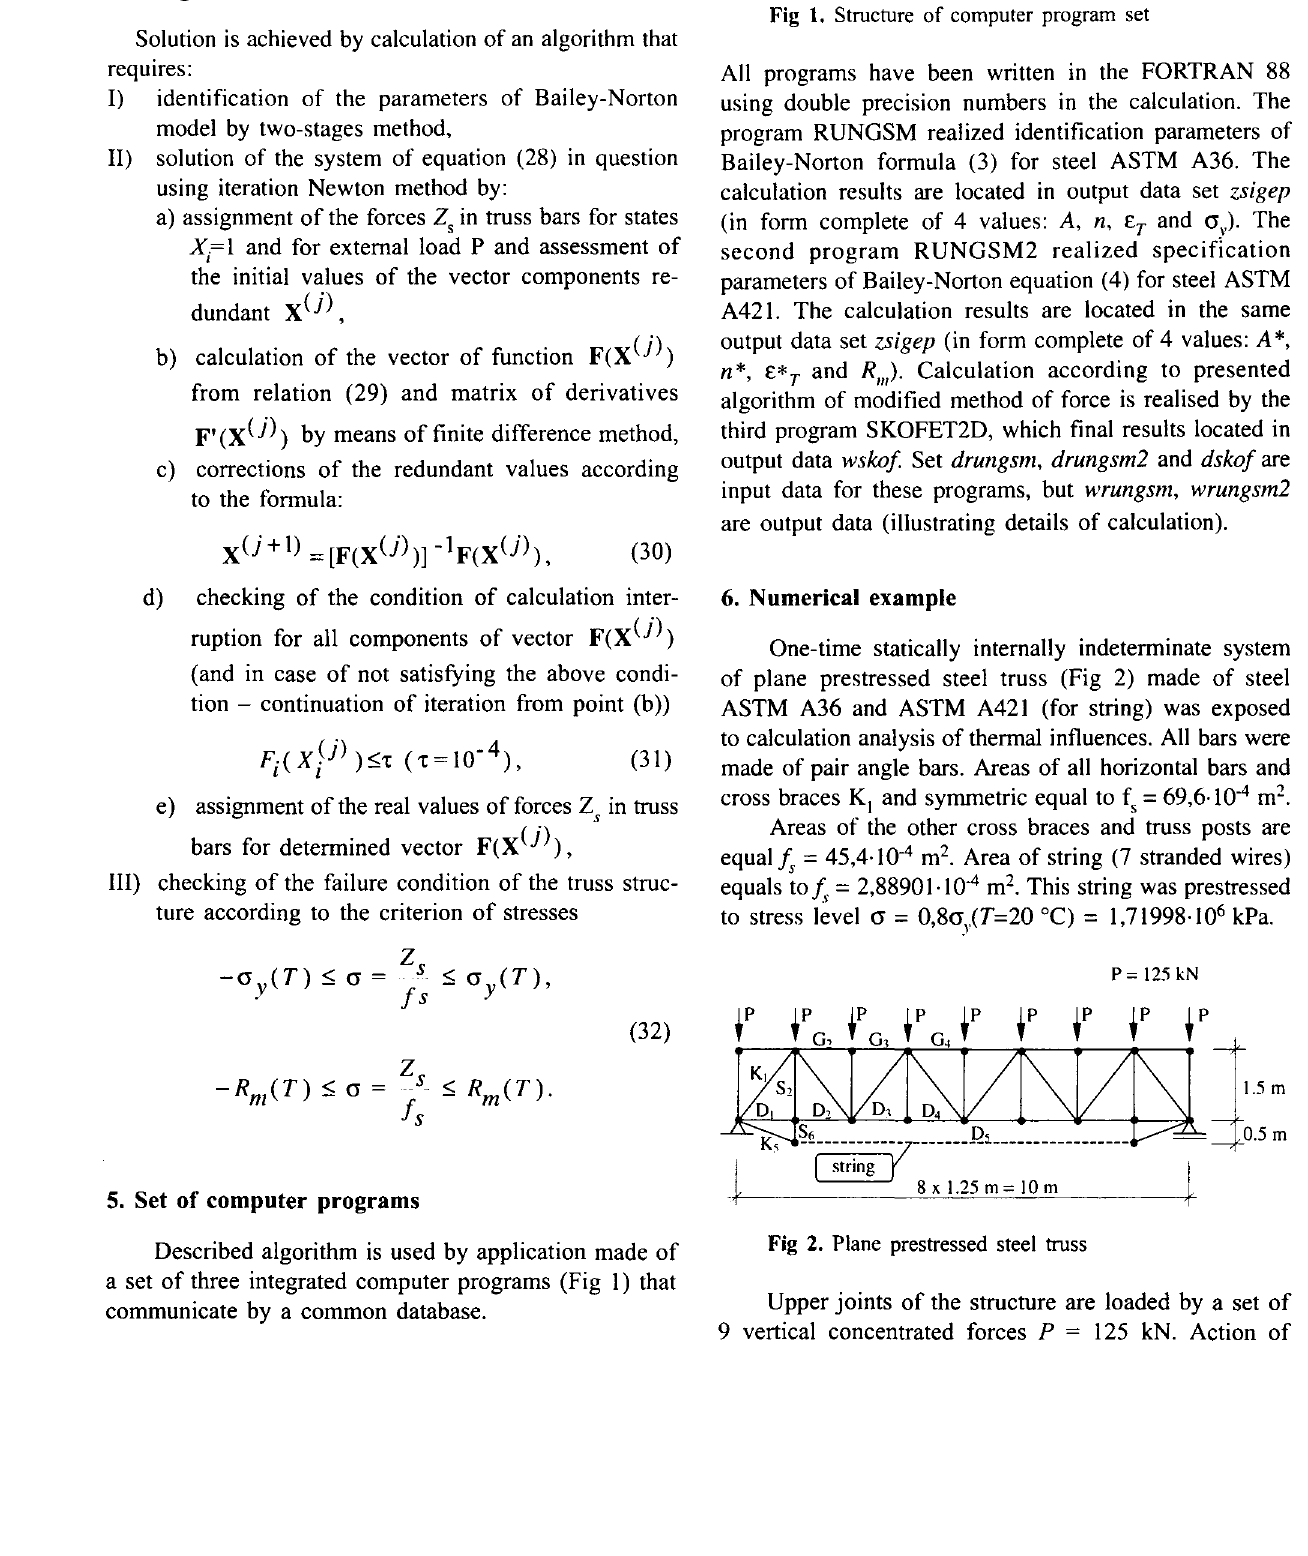
Fig 1. Structure of computer program set